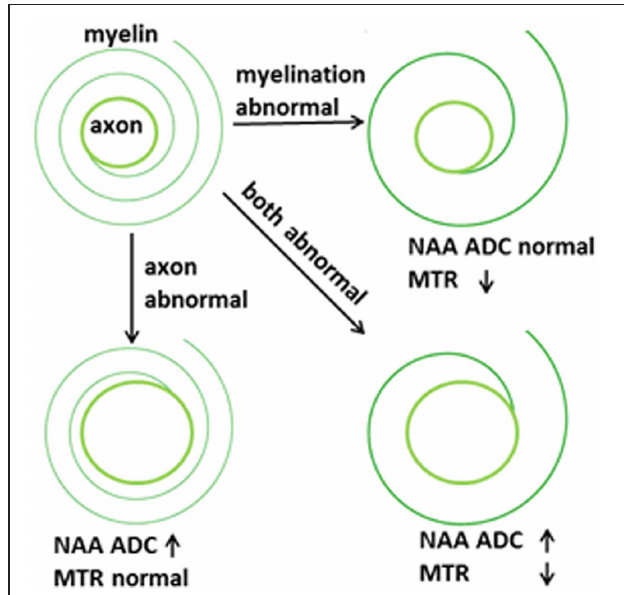
FIGURE 3 | Proposed abnormalities in